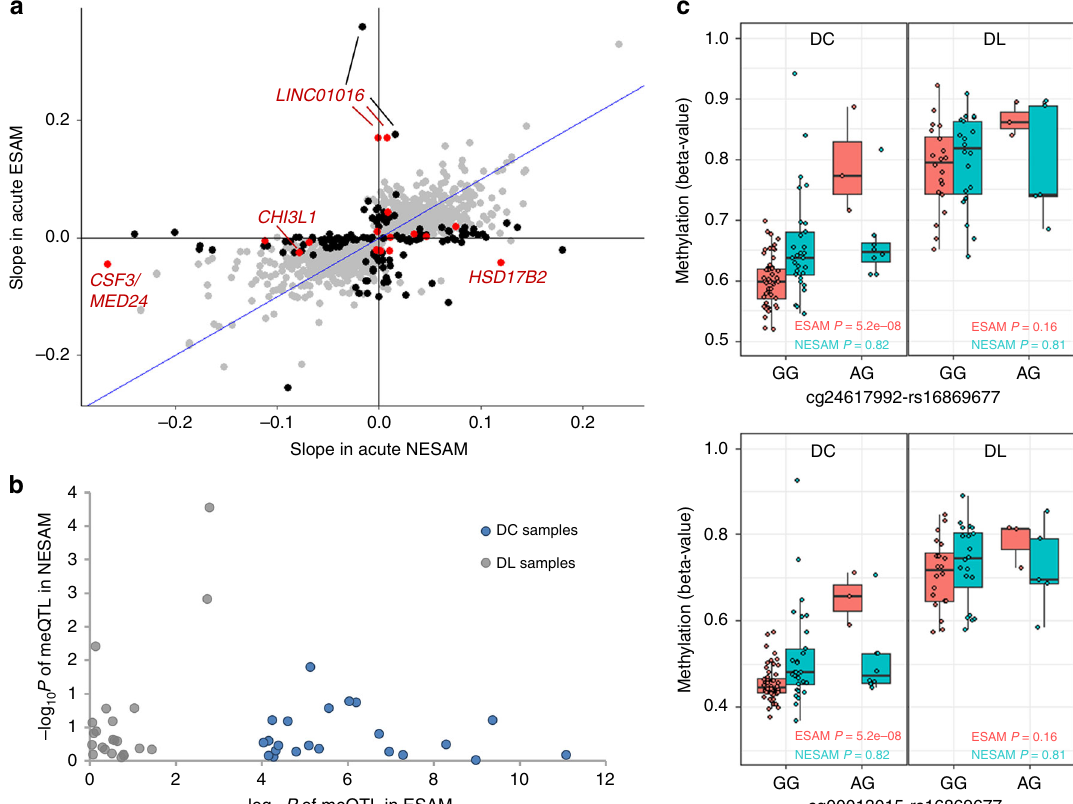
Fig. 5 A model of nutrition-sensitive methylation quantitative trait loci (meQTLs). a Scatterplot of the slopes of the regressions ( β 1 ) of SNP genotype on CpG methylation (meQTLs) at signi fi cant DMCs in acute (DC) ESAM and NESAM samples ( N = 1885 SNP − DMC pairs). FDR-signi fi cant DMCs with meQTLs showing a signi fi cant interaction ( t test, P ≤ 0.05) between ESAM and NESAM DC samples, but not among DL samples ( N = 162) are highlighted in black; similar meQTLs found at Bonferroni-signi fi cant DMCs ( N = 16) are in red. b log 10 transformed P values of 162 meQTLs with a signi fi cant interaction; each dot represents values for the same SNP − CpG pair between acute (DC NESAM vs. DC ESAM) and recovered (DL NESAM vs. DL ESAM) individuals. c Disease context-dependent meQTLs at LINC01016 . Methylation beta values ( y axis) and genotypes ( x axis) are shown for two adjacent SNP − CpG pairs (one SNP — two CpGs) illustrating a signi fi cant ESAM − NESAM interaction ( t test, P ≤ 0.05; positive regression slope) in acute (DC, top and bottom left panels, N ESAM = 53 samples, N NESAM = 37 samples) but not recovered SAM (DL, top and bottom right panels, N ESAM = 23 samples, N NESAM = 25 samples). Boxplot center lines are medians, box boundaries are fi rst and third quartile, and whiskers extend to data points found within 1.5 times the length of inter quartile range from the